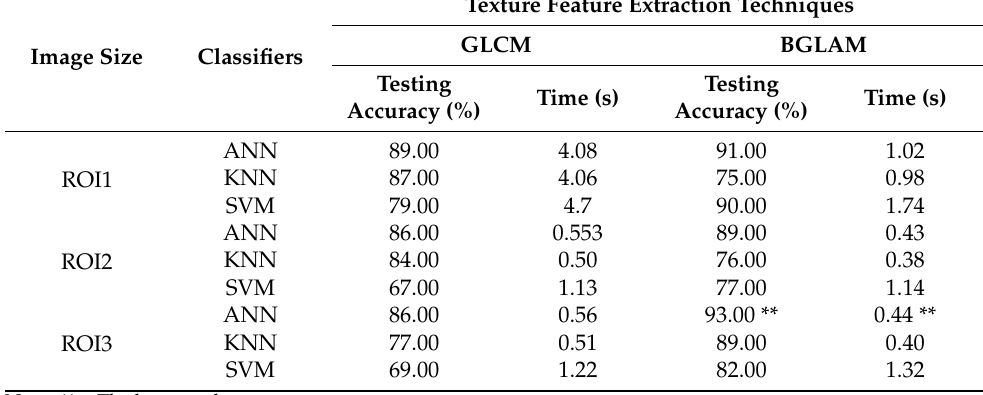
Table 5. Results of test computing FFB type classification based on GLCM and BGLAM using ANN, KNN and SVM.